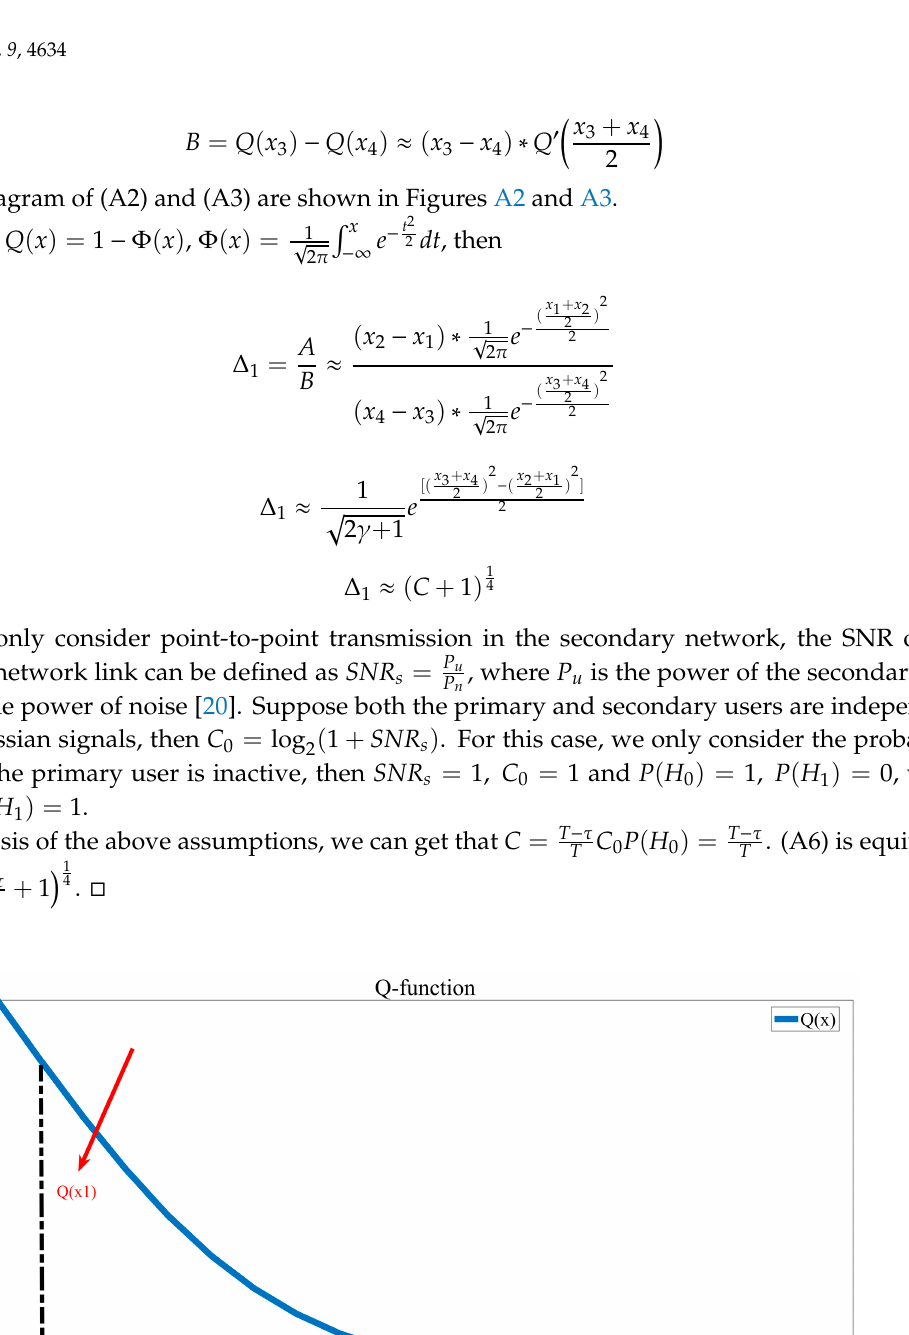
Figure A3 . Approximate schematics of Area A and B References 1.